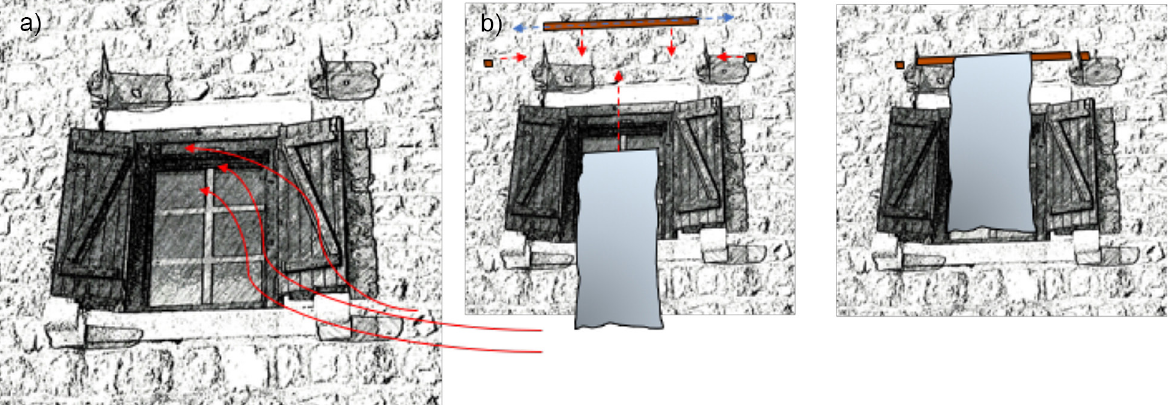
Fig. 7a. Existing natural ventilation. Fig. 7b. Revitalised method for existing natural ventilation, ensuring the needed shade and humidity in the hot season. Architectural structure of the city of